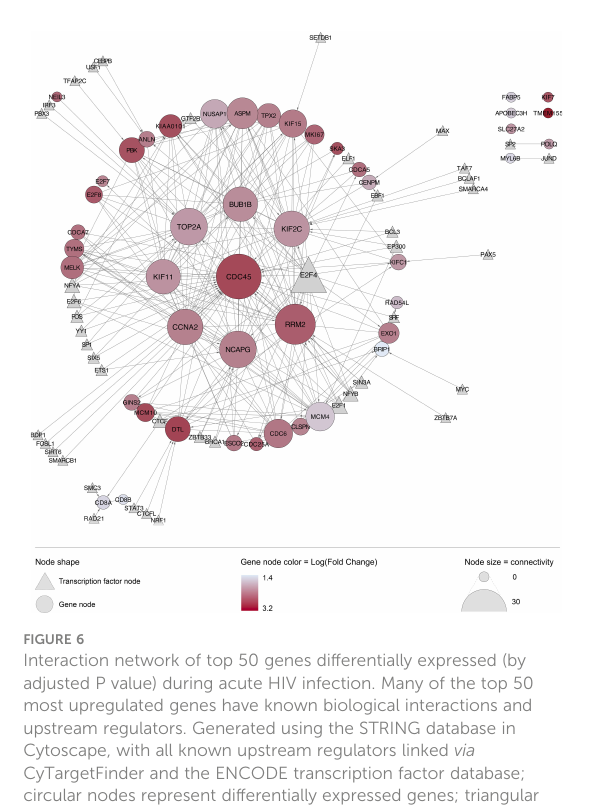
FIGURE 6 Interaction network of top 50 genes differentially expressed (by adjusted P value) during acute HIV infection. Many of the top 50 most upregulated genes have known biological interactions and upstream regulators. Generated using the STRING database in Cytoscape, with all known upstream regulators linked via CyTargetFinder and the ENCODE transcription factor database; circular nodes represent differentially expressed genes; triangular nodes represent upstream transcription factors; edges, shown as grey lines, represent known biological interactions with the arrow indicating direction of interaction (source to target); node color for genes re fl ects log 2 fold change value (more red = more signi fi cantly differentially expressed, all upregulated in this case); node size represents degree of connectivity to other nodes in the network.